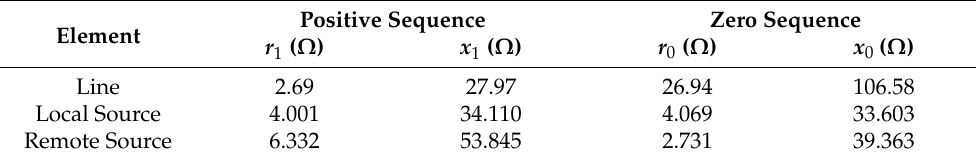
Table 3. Line parameters and equivalent